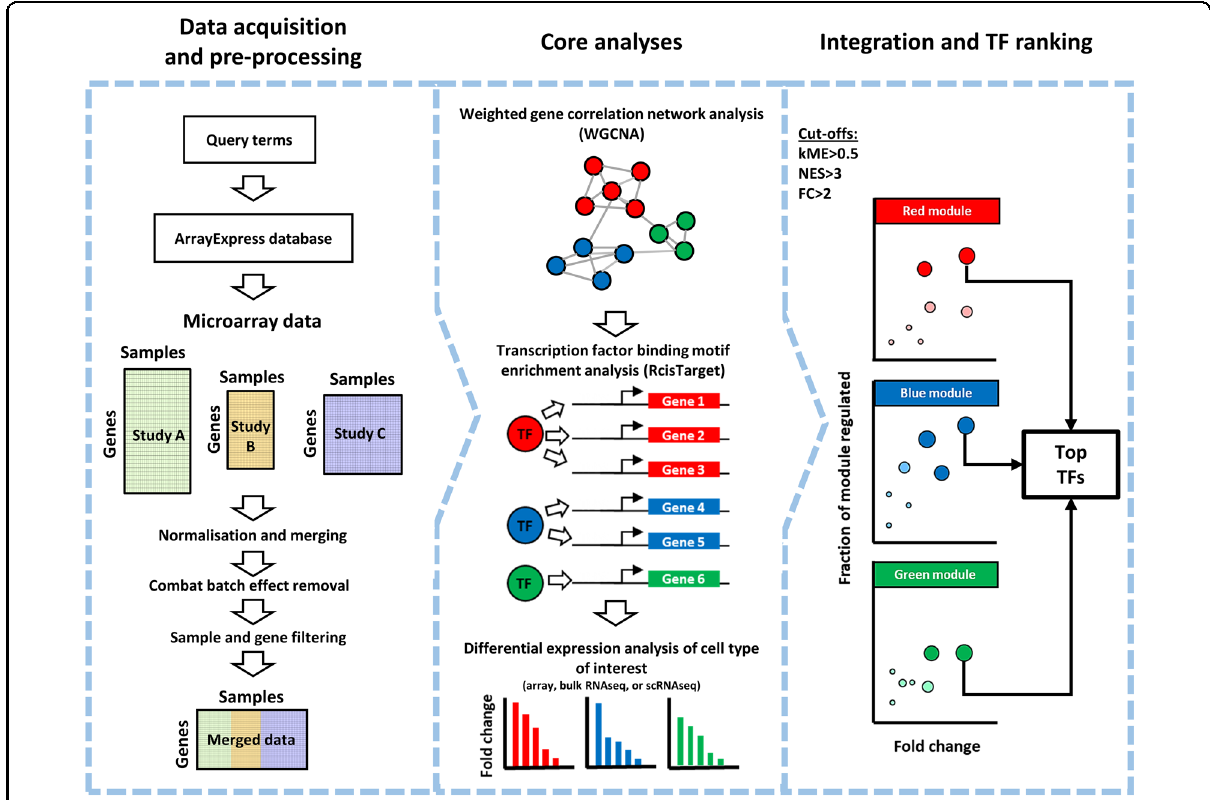
Fig. 2 CenTFinder computational work fl ow. Schematic overview of the CenTFinder work fl ow for identi fi cation of TFs (central in differentiation and speci fi cation). Left panel: data acquisition and pre-processing. The analysis starts by de fi ning queries that are used for fi ltering and retrieving relevant expression data from the ArrayExpress database. Retrieved microarray data (of different formats) are combined and normalised and batch corrections are applied. Alternatively, a pre-processed expression matrix can be provided as input. Middle panel: core analyses. The expression matrix is subsequently subjected to gene co-expression analysis (WGCNA), TF binding motif enrichment analysis ( RcisTarget ), and the results are overlapped with differential expression analysis. Right panel: integration and TF ranking. The last step in the work fl ow is to combine the output of WGCNA, RcisTarget , and differential expression analyses to prioritise and rank TFs. Additional downstream analyses, e.g., Gene Ontology enrichment, and Cytoscape network visualisations are performed at this